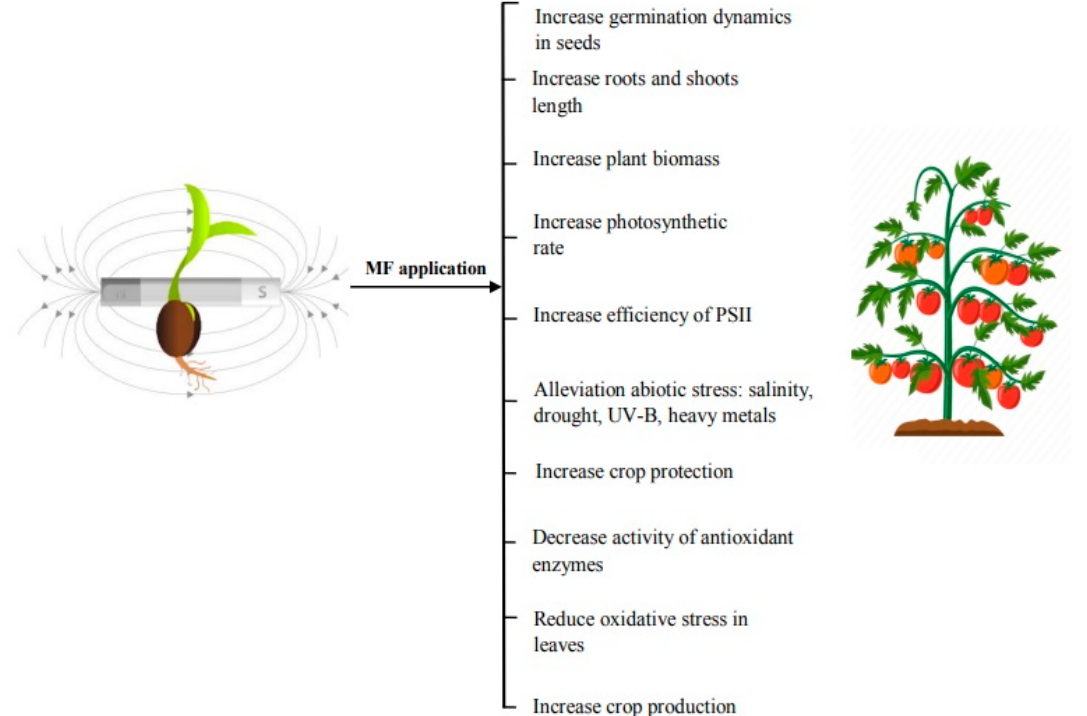
Figure 2. The various morphological, physiological, and biochemical effects of magnetic field on the plants .